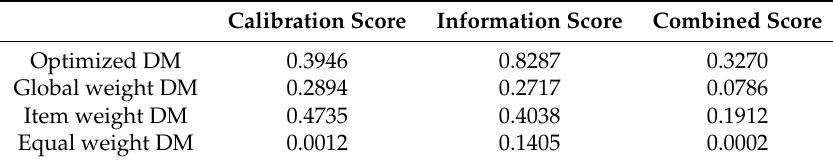
Table 2. Performance of the different Decision Makers (DM’s) for panel